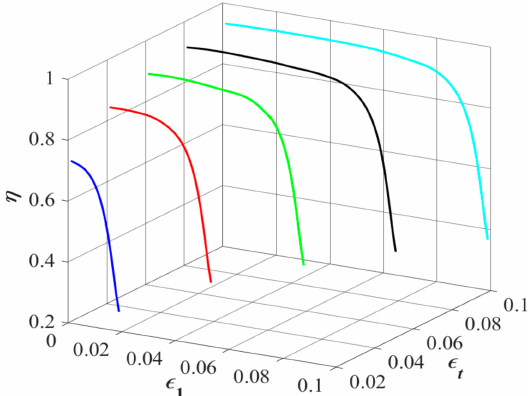
Figure 15. The variation of efficiency of the five NESs with the mass coefficient of N 1